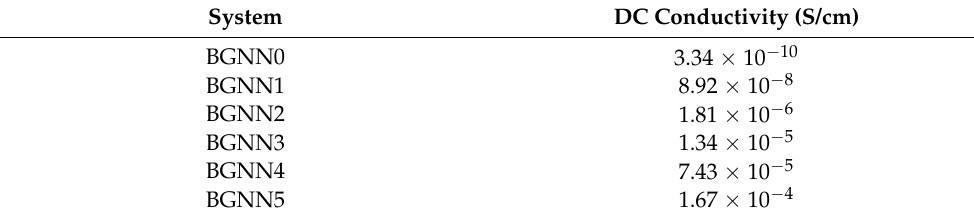
Table 2. Values of DC conductivity for all NBG electrolytes.